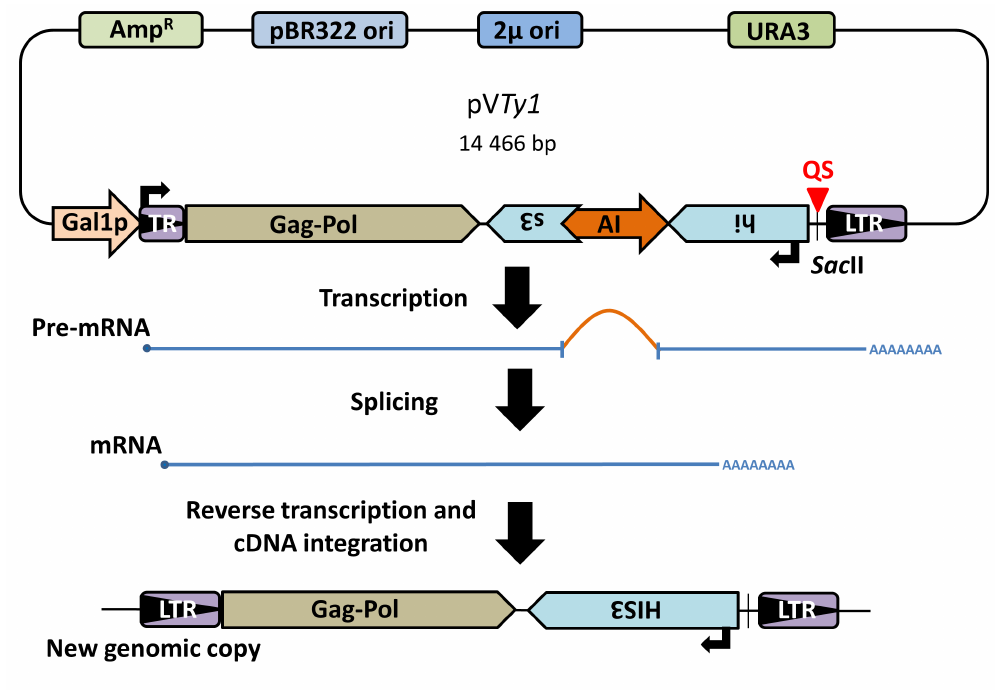
Figure 1. Schema of plasmid containing Ty1his3AI retrotransposon and element retrotransposition. Plasmid borne chimeric Ty1 element contains retrotransposition indicating HIS3 gene in opposite orientation with respect to Ty1 transcription. The HIS3 gene is disrupted by an artificial intron (AI), which is spliceable only when transcription starts from an inducible Gal1 promoter (Gal1p). After splicing and reverse transcription, the new Ty1 genomic copy contains functional HIS3 and yeast can be grown on selective plates without histidine. TR-5 (cid:48) truncated